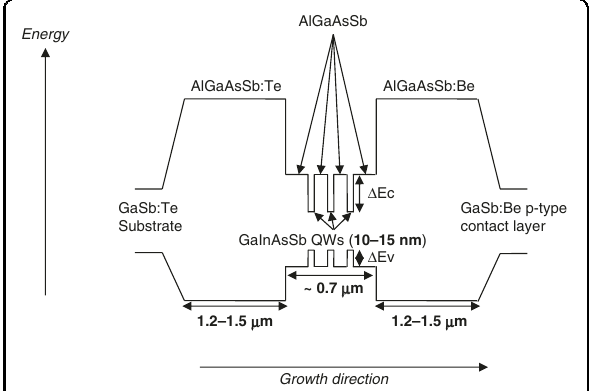
Fig. 4 Typical band structure of a type-I QW GaInAsSb/AlGaAsSb diode laser emitting in the 2 – 3 μ m wavelength range. The materials used in the different layers are indicated together with their typical